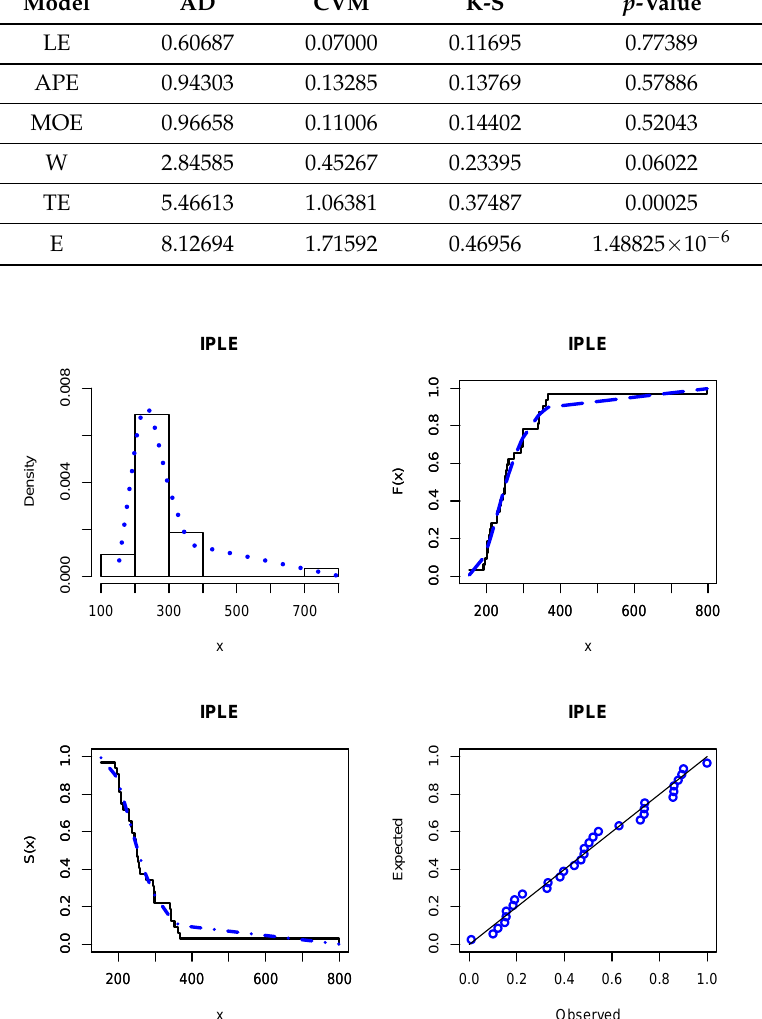
Figure 4. Histogram of the insurance dataset with the fitted IPLE PDF, CDF, survival function (SF), and P-P